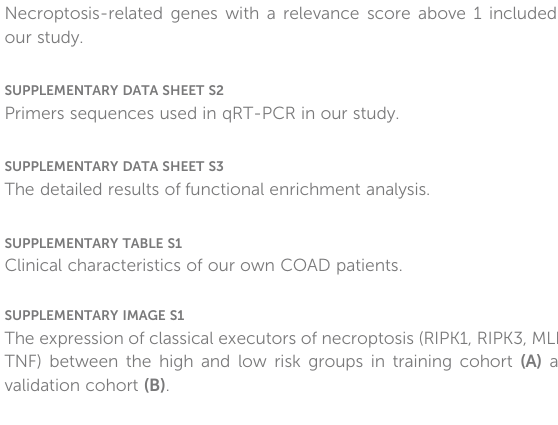
SUPPLEMENTARY DATA SHEET S1 Necroptosis-related genes with a relevance score above 1 included in our study.